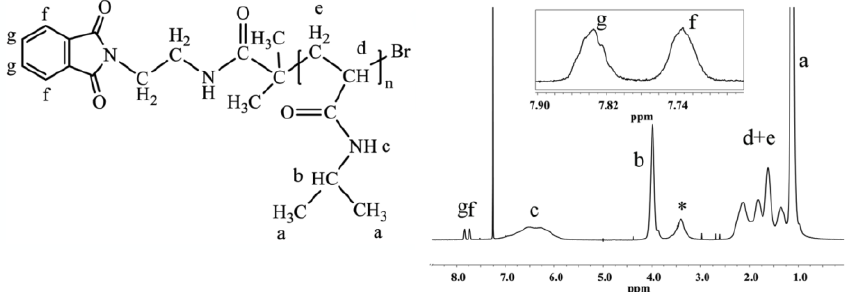
Figure 1. 1 H-NMR spectrum of PNIPAAm prepared with phthalimide protected initiator with magnification of the end-group area. The end-group protons give multiplets isolated from peaks of the polymer backbone. The spectrum was recorded in CDCl 12 s relaxation delay (determined by T1 test), (*, water).